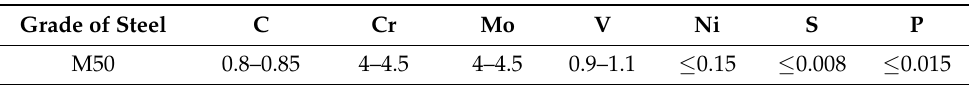
Table 1. The chemical composition of the main elements of M50 bearing steel. (%, mass fraction). Grade of Steel C Cr Mo V Ni M50